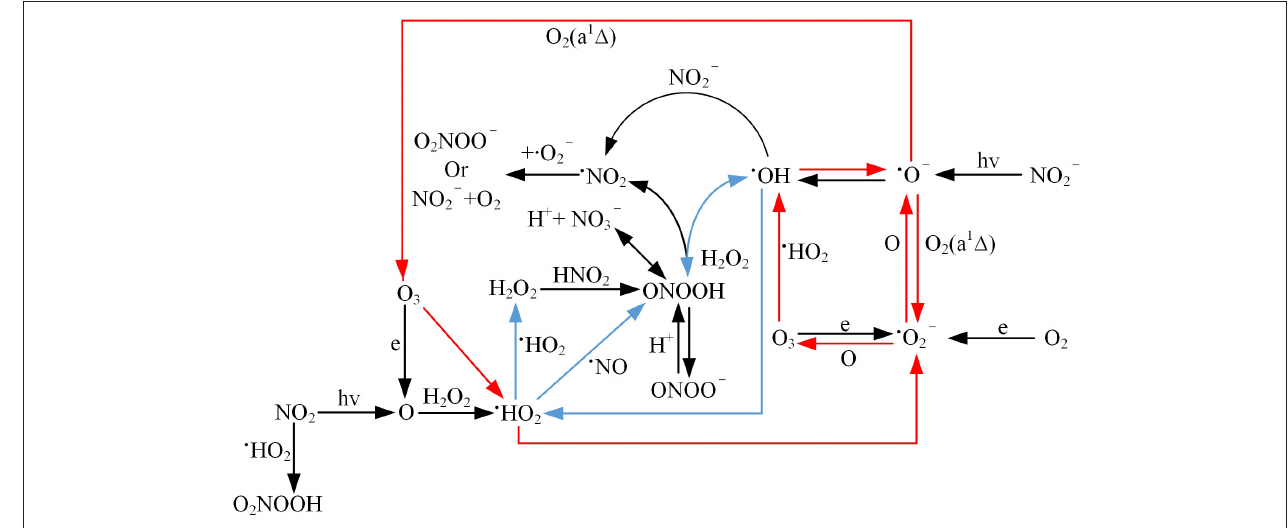
FIGURE 11 | Schematic diagram of several chemical reactions that occur in PAW.